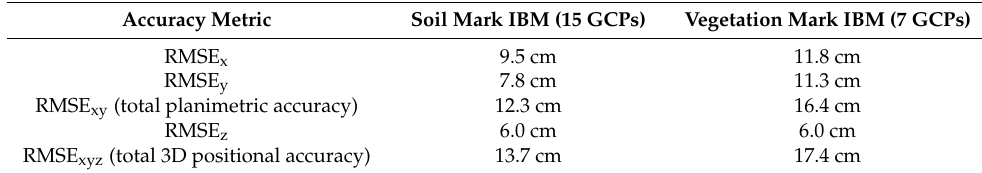
Table 1. Georeferencing accuracy metrics of the computed 3D